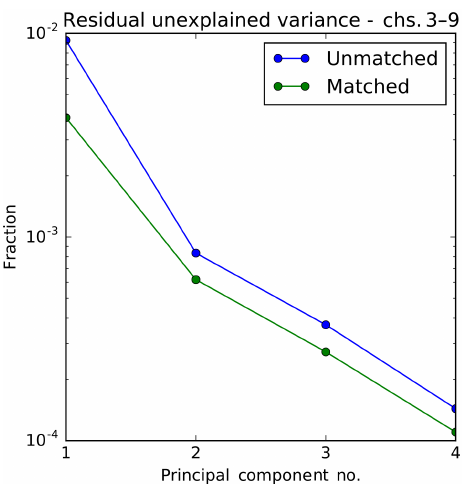
Figure 10. The residual unexplained variance after accounting for the first through fourth principal components (eigenvectors) of the covariance of the 18.7 through 89.0GHz channels for the coastal data depicted in Fig.